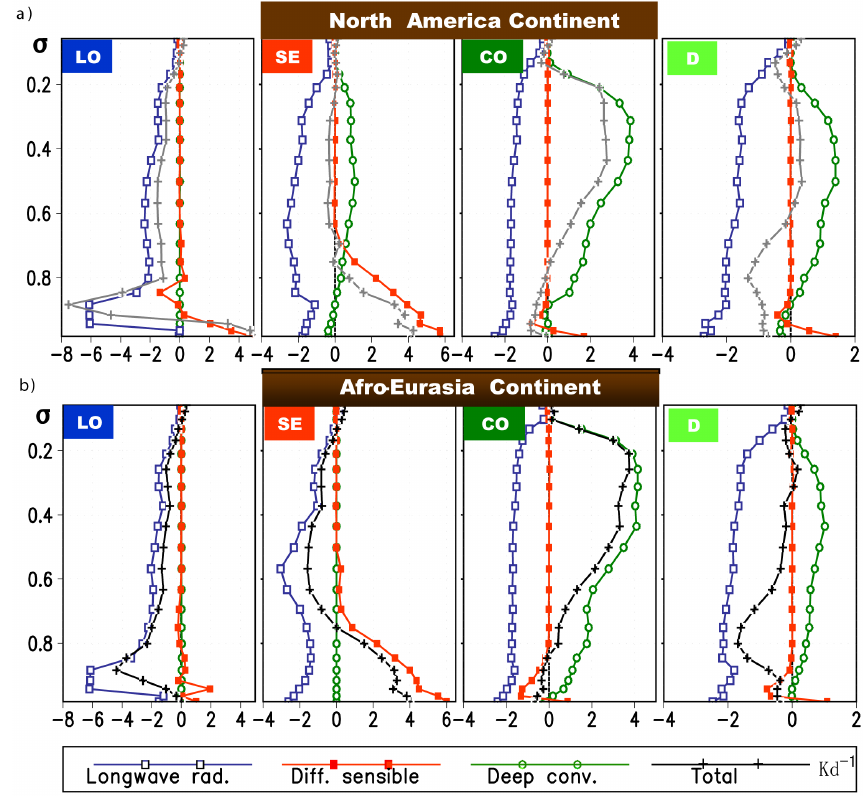
Fig. 5. July mean vertical heating profiles in sigma ( σ) coordinates for locations LO, SE, CO, and D (see Fig. 6b for locations) across (a) North America and adjacent oceans, and (b) the Afro-Eurasian Continent and adjacent oceans (after Wu and Liu, 2003; Liu et al., 2004). The lines with open squares, filled squares, open circles, and “plus” signs represent long-wave radiative cooling (LO), diffusive sensible heating (SE), deep convective condensation heating (CO), and total heating, respectively. Unit is Kd − 1